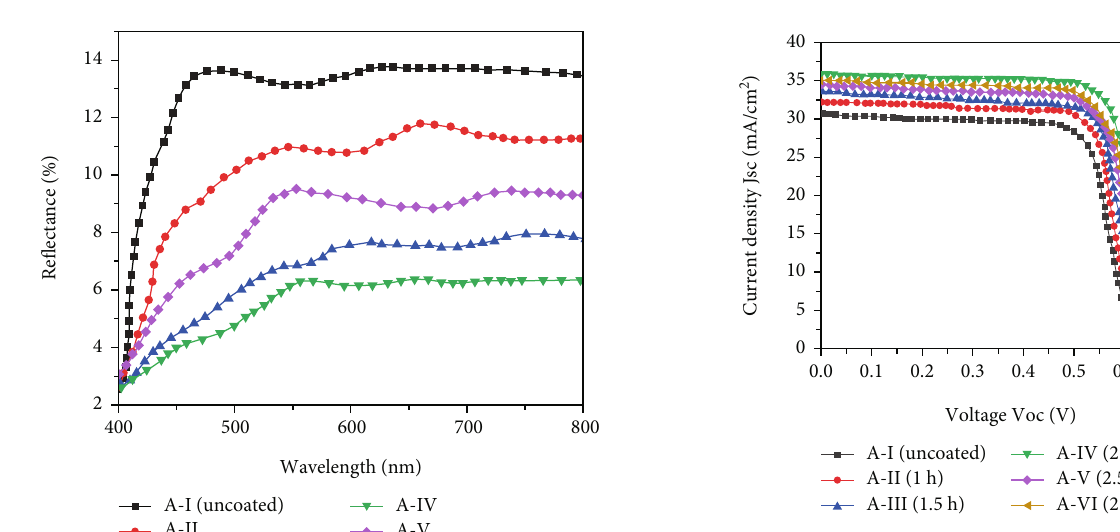
Figure 8: I-V plot of the samples under direct sunlight. -coated cells. Table 5: Values of I-V measurement of samples under a controlled 2 environment.